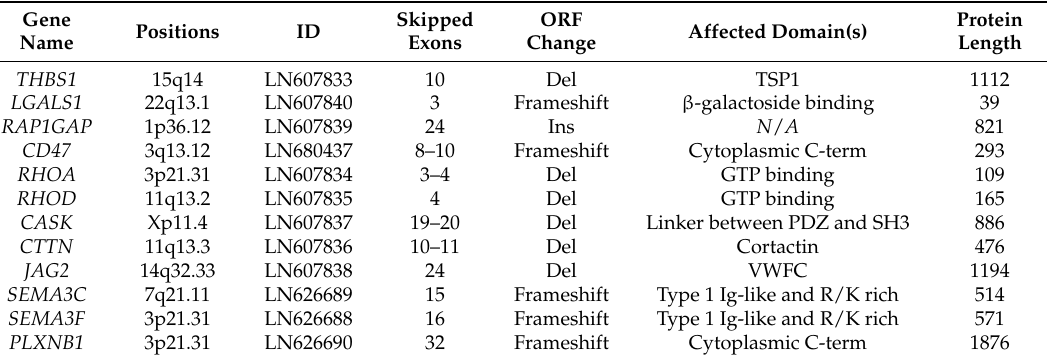
Table 1. Summary of new validated transcripts and of their predicted